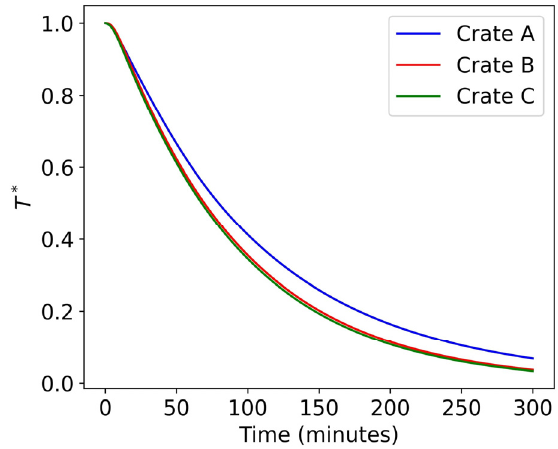
Figure 15. Influence of crate design on the cooling kinetics of the products for a pressure drop of 4.5 Pa between the inlets and the outlets of the pallet layer. 4.5 Pa between the inlets and the outlets of the pallet